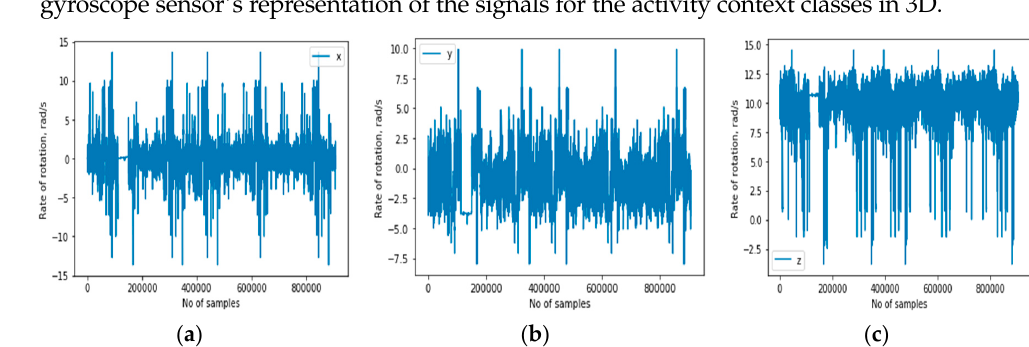
Figure 5. 3-D gyroscope signals representing all activity contexts.( a ), ( b ), and ( c ) respectively are the x, y, and z axes of the gyroscope sensor.